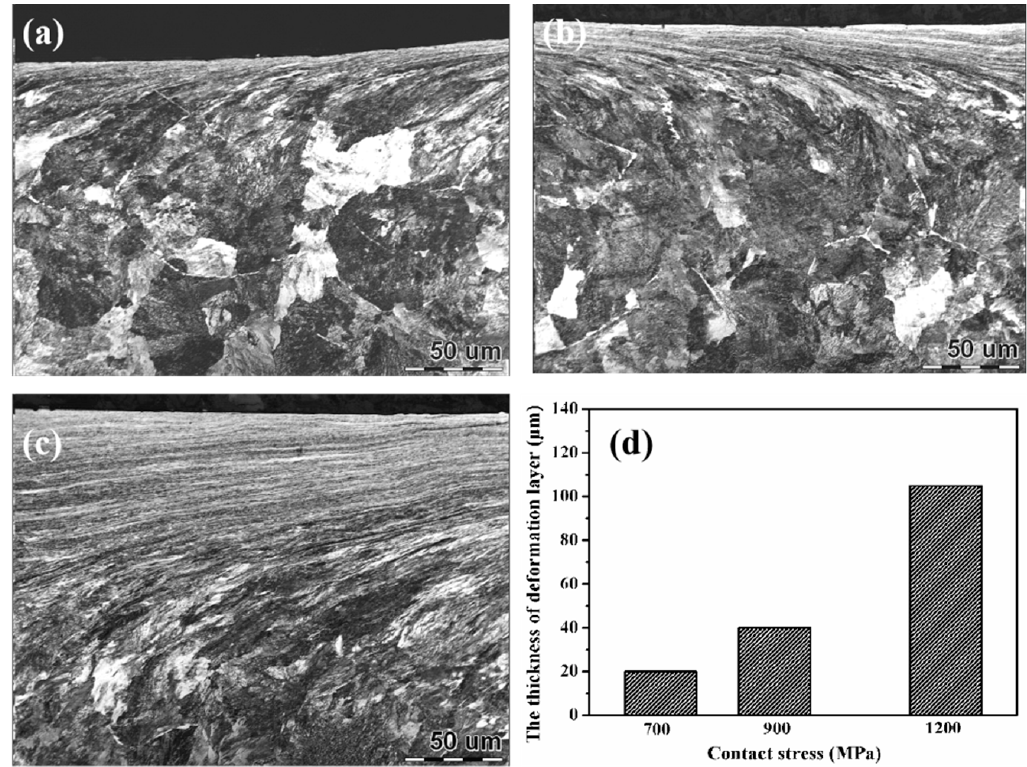
Figure 9. The OM micrographs of rail samples under different contact stress conditions: ( a ) 700 MPa;